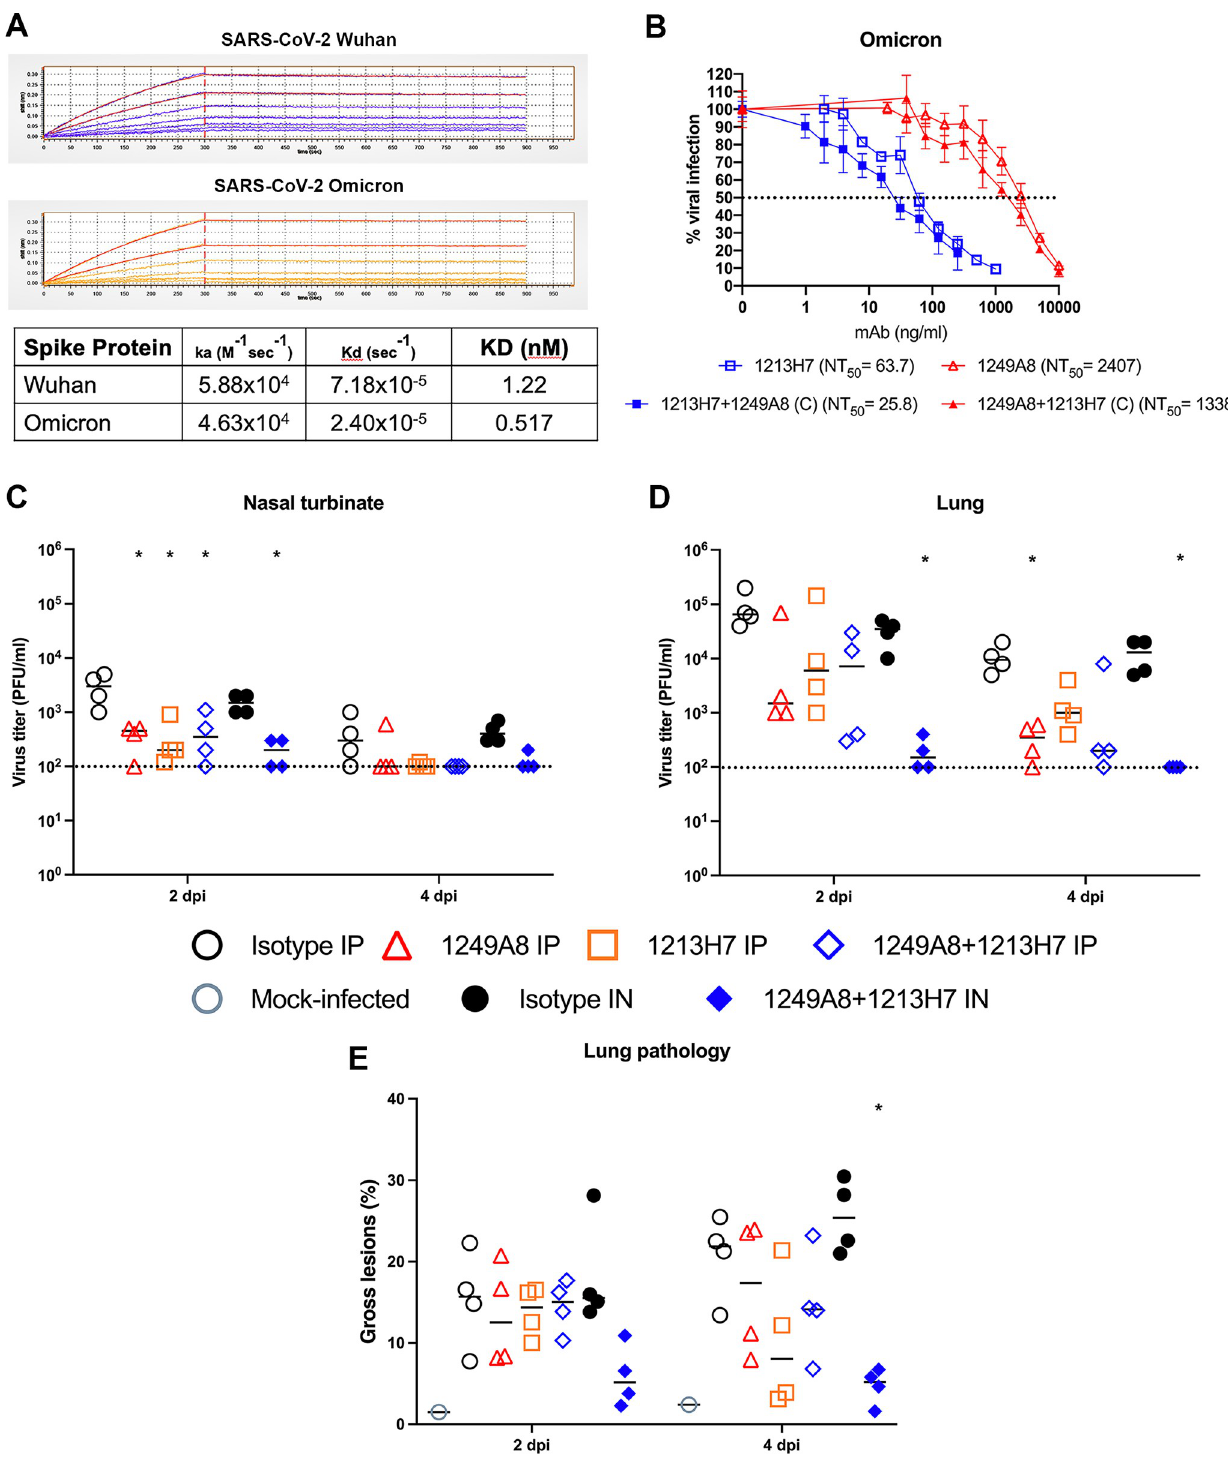
Fig 5. Neutralization and prophylactic in vivo activity of 1249A8 and 1213H7 against SARS-CoV-2 Omicron. ( A ) Binding of 1249A8 (60, 40, 27, 18, 12 nM) to SARS-CoV-2 Wuhan and Omicron Spike protein determined by BLI. ( B ) Vero AT cells were infected with 600 pfu SARS-CoV-2 Omicron (BEIR) and after 1 h of viral adsorption, the indicated mAb(s) was added and at 24 h.p.i infected cells were fixed for virus titration by immunostaining assay. 1213H7 and 1249A8 were tested alone (open symbols) and together keeping 1213H7 constant (C) (50 ng/ml) or 1249A8 constant (2 μ g/ml) and titrating the reciprocal mAb (closed symbols). Resulting NT 50 (ng/ml) are indicated. K18 hACE2 mice were treated with 1249A8 (40 mg/kg), 1213H7 (10 mg/kg), or